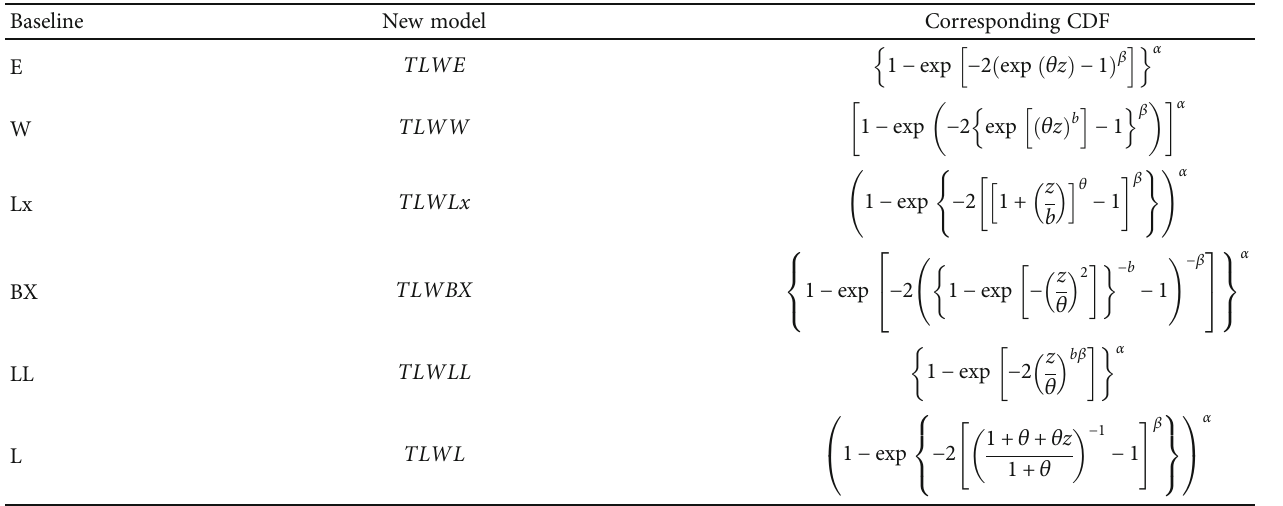
Table 1: Special